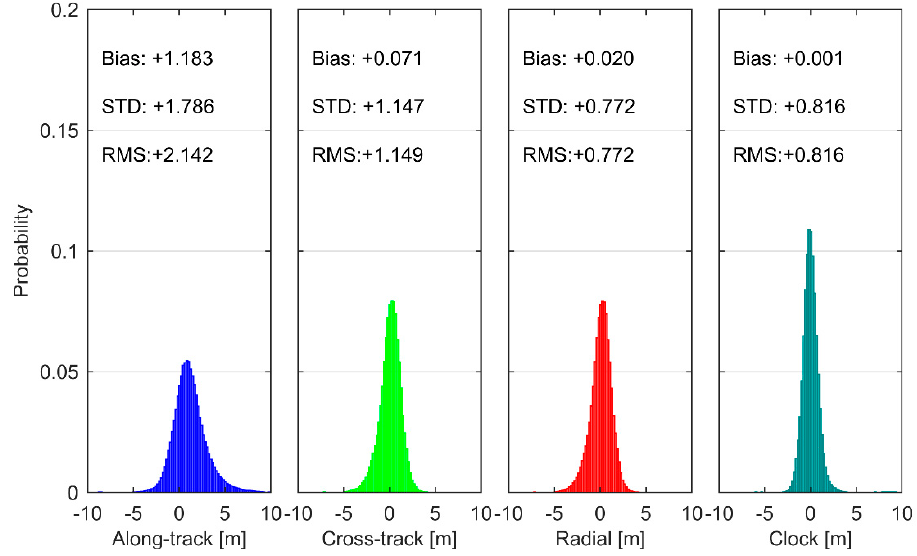
Figure 5. The distribution of SBAS-derived orbit and clock errors for EGNOS PRN 123.